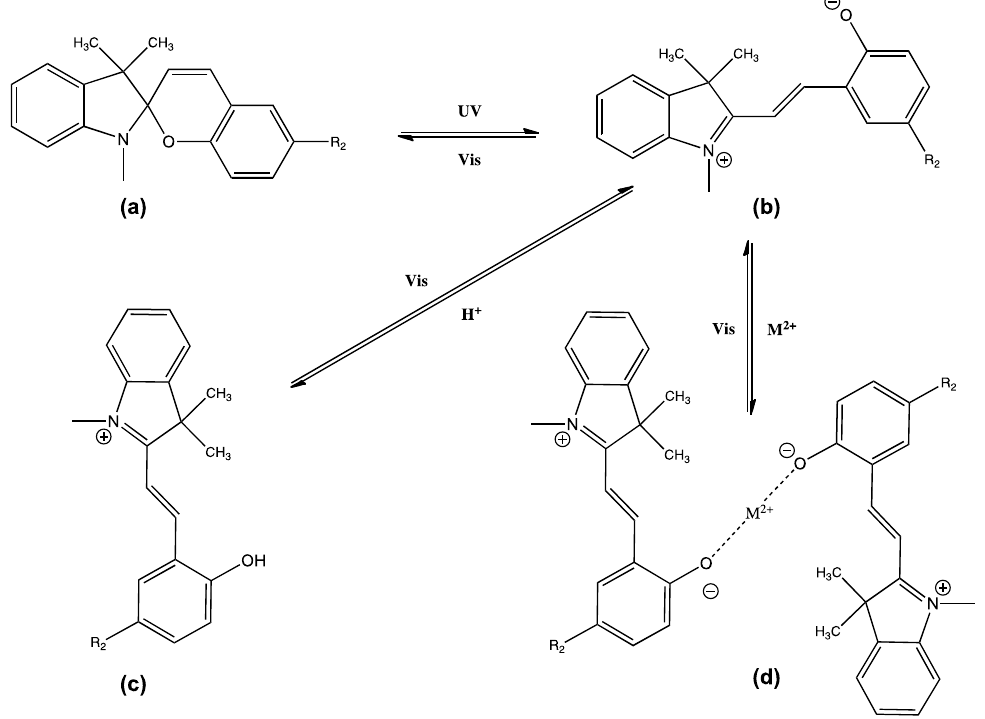
Figure 4. The photodynamic, pH and metal-ion chemistry of Spiropyran (SP)